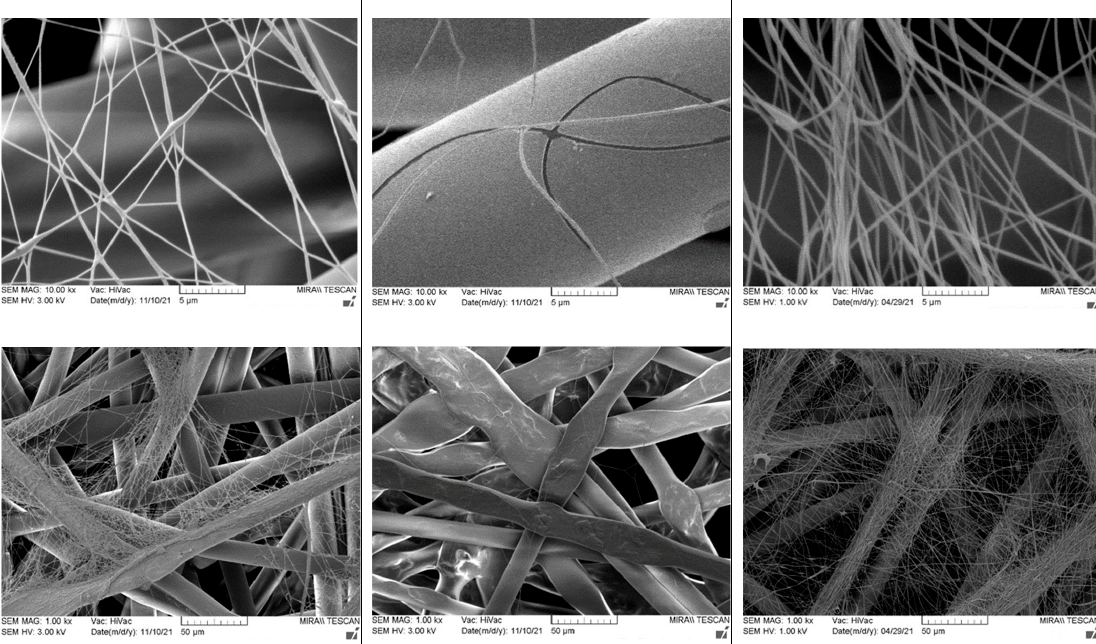
Figure 7. Electrospun membranes of sample 6PVA130 with an electrode distance of 180 mm using fixed-wire (left), five-rotating-wire (center), and rotating cylinder-type (left) electrodes. fixed-wire ( left ), five-rotating-wire ( center ), and rotating cylinder-type ( left )